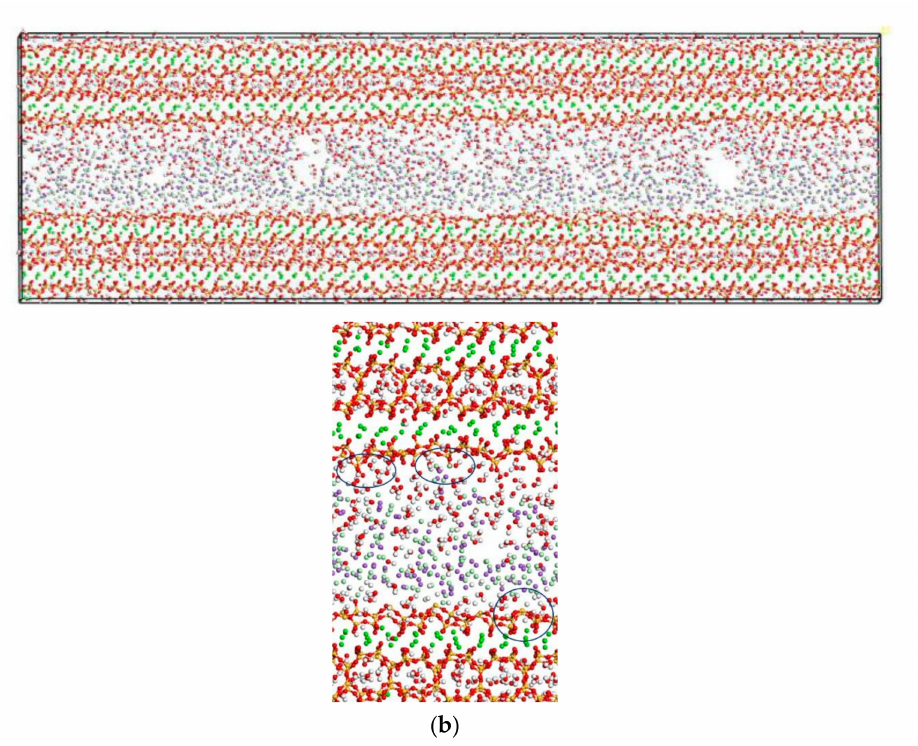
Figure 6. Transport properties of NaCl in C-S-H nanopores with di ff erent pore sizes (green balls are Ca 2 + , yellow balls are Si atoms, purple balls are Na + , light green balls are Cl − , red balls are O atoms, white balls are H atoms). ( a ) Pore diameter: 1.5 nm. ( b ) Pore diameter: 3